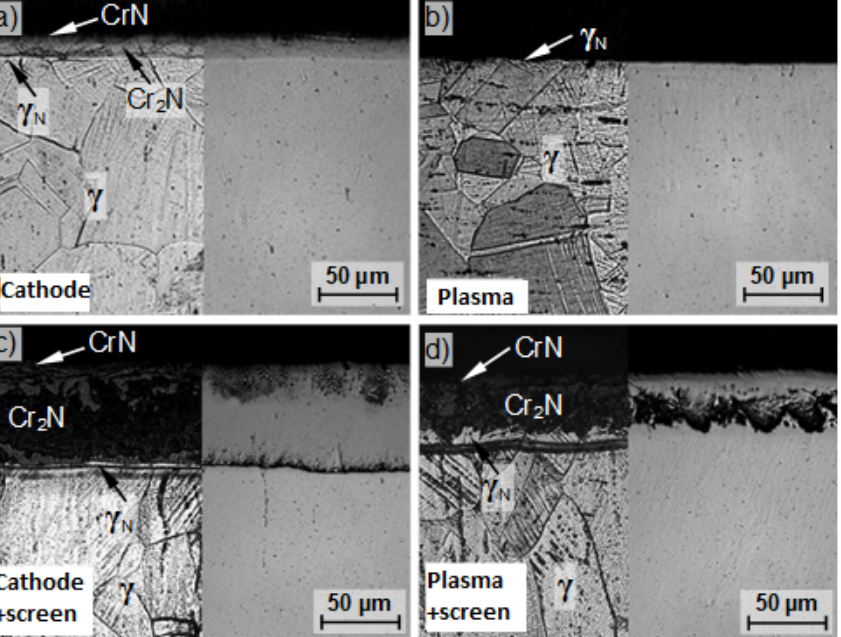
Figure 2. Microstructure of nitrided layers on the substrate of X2CrNiMo17-12-2 steel for different variants of the position of samples in the glow chamber: ( a ) Cathode, ( b ) plasma, ( c ) cathode + screen, and ( d ) plasma + screen. Temperature T = 490 ◦ C , time t = 14 h.